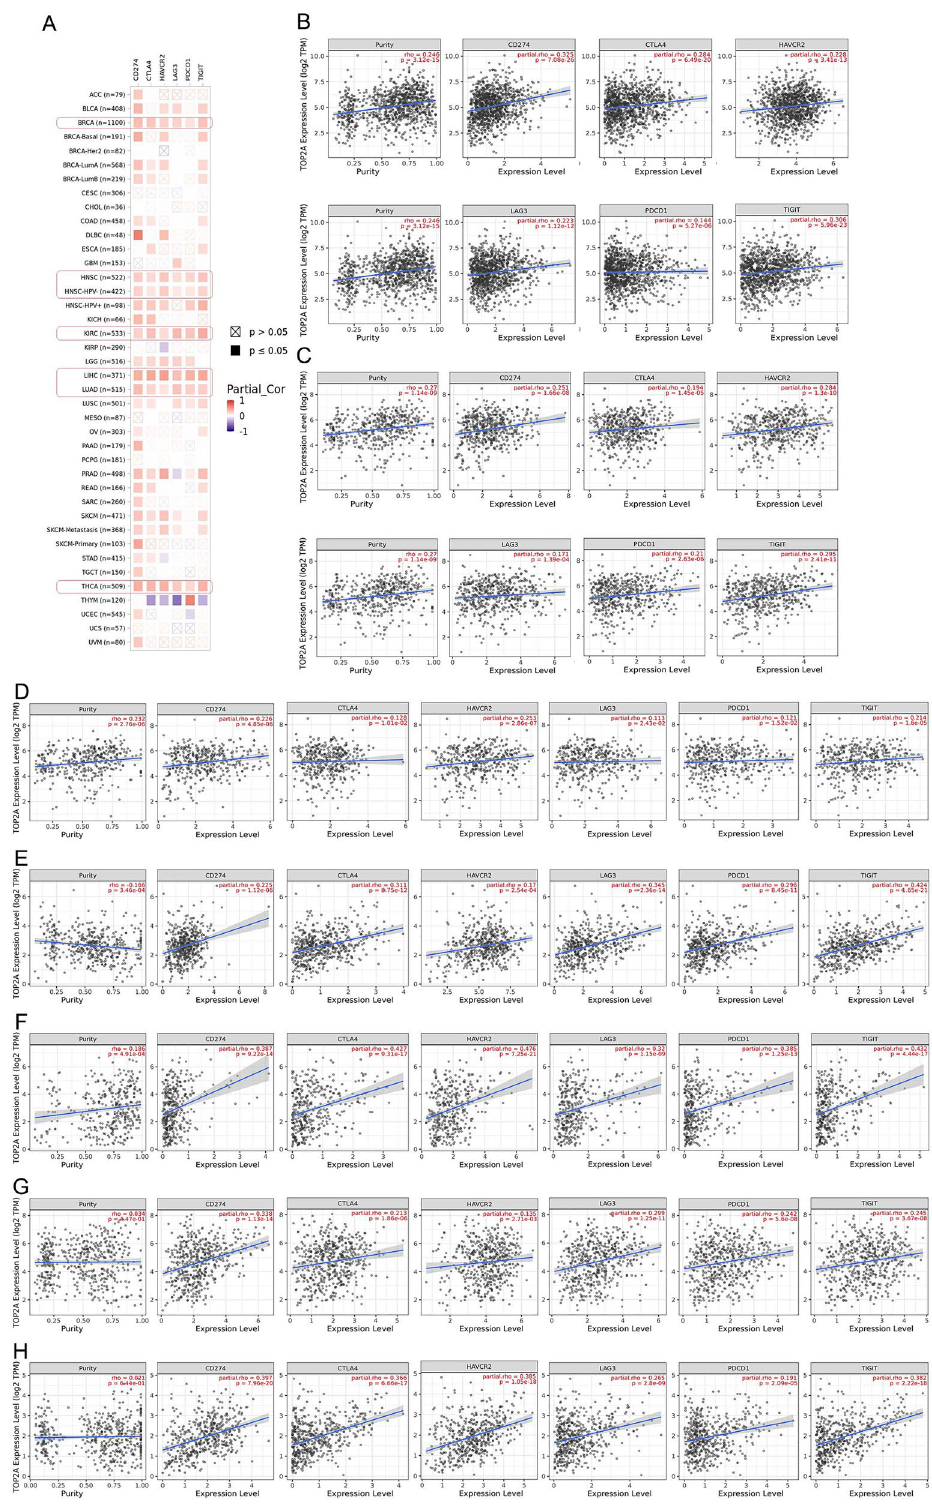
Figure 8. Correlation between TOP2A and immune checkpoints. ( A ) Correlation between TOP2A and immune checkpoints in multiple tumors. ( B – H ) Correlation between TOP2A and immune checkpoints